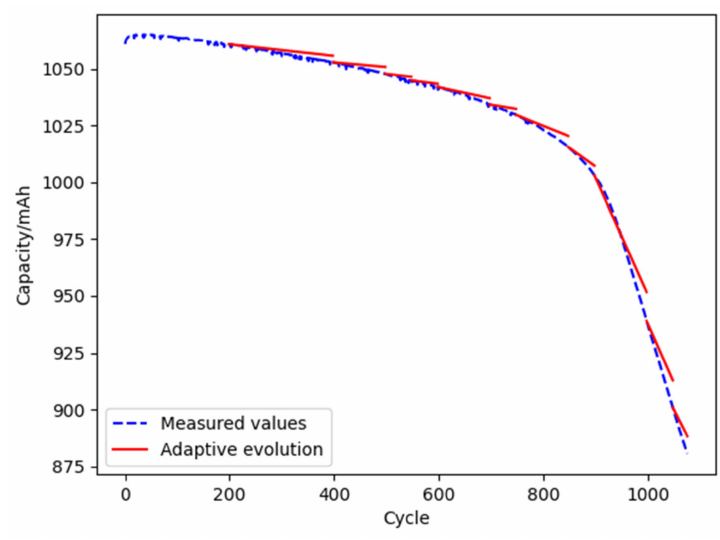
Figure 14. Evolution of the digital twin model based on open-source datasets. Table 9. The result of model evolution based on open-source